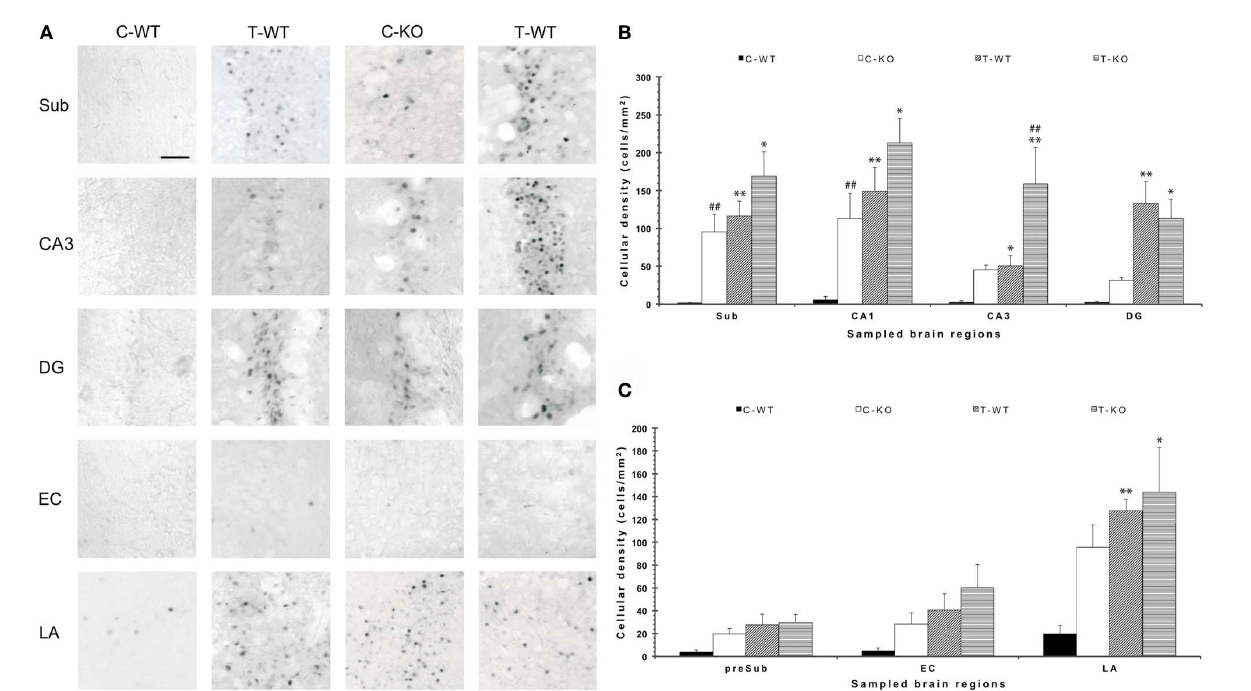
EC and LA. ∗ P < 0 . 05, ∗∗ P < 0 . 01, acoustically stimulated group vs. the respective unstimulated group; ## P < 0 . 01, Fmr1 KO vs. WT mice with similar treatment (tested or not tested). Three-way ANOVA followed by LSD test. C-WT, WT mice not exposed to auditory stimulus; T-WT, WT mice exposed to the audiogenic test, C-KO, Fmr1 KO mice not exposed to auditory stimulus; T-KO, Fmr1 KO mice tested; Sub, subiculum; CA, cornu Ammonis; DG, dentate gyrus; EC, entorhinal cortex; LA, lateral